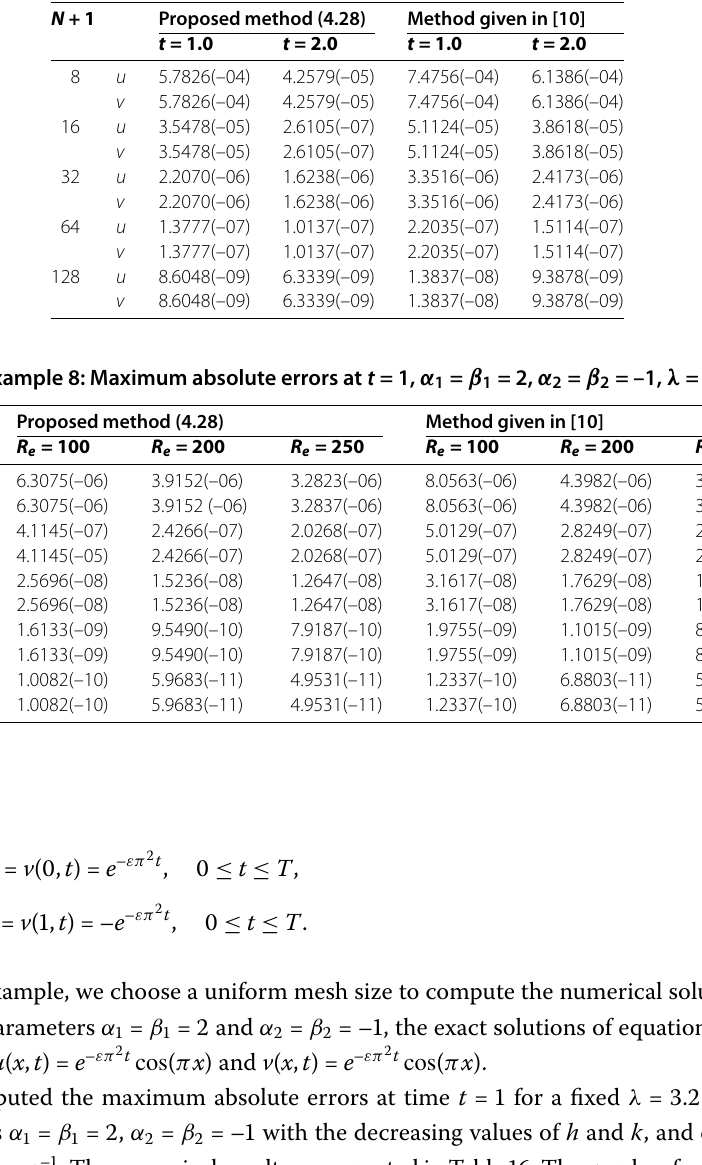
Table 15 Example 7: Maximum absolute errors, ε = 1, α 1 = β 1 = –2, α 2 = β 2 = 1, λ = 1.6/4 π 2